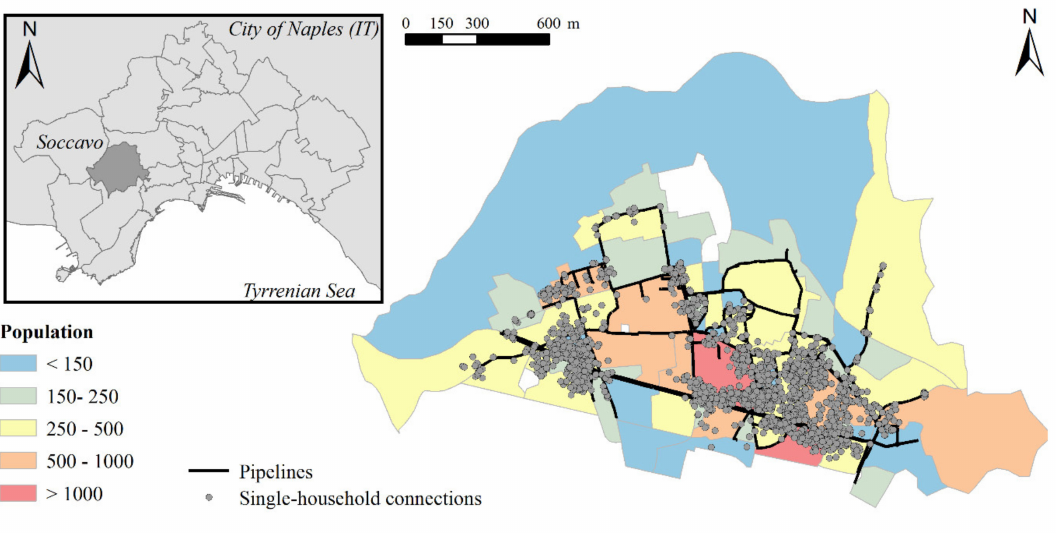
Figure 1. Pilot area: Water distribution network, water meters, and census